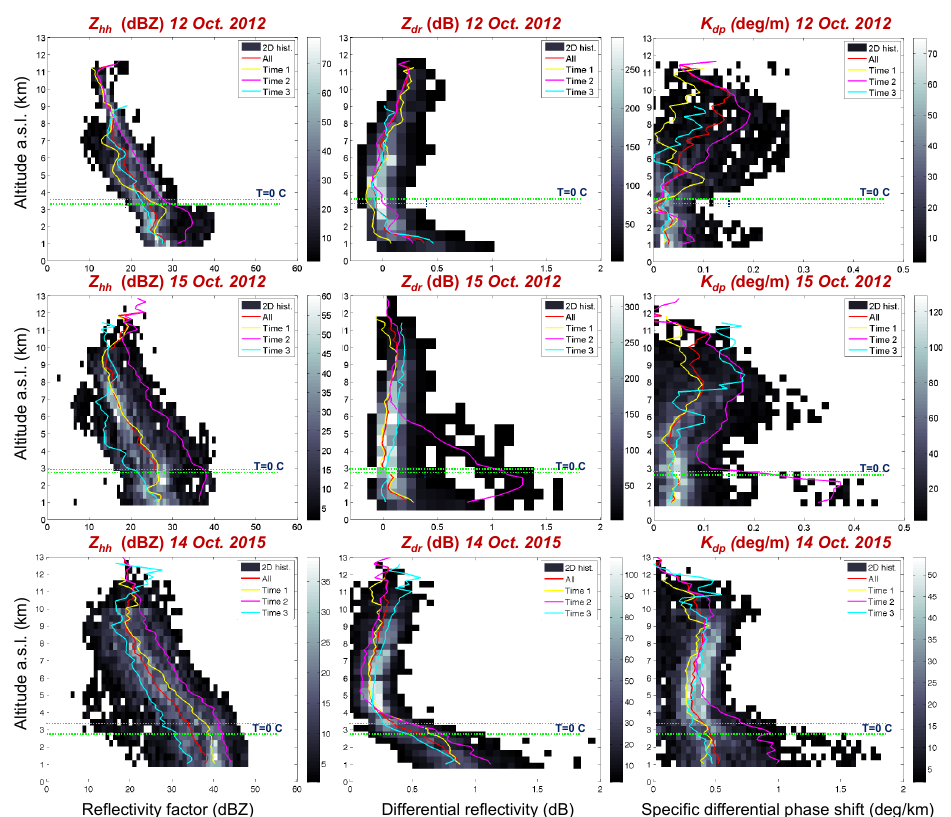
Figure 3. From left to right: average quasi vertical profiles of Z hh (dBZ), Z dr (dB), and K dp (deg · km − 1 ), extracted from three time windows as specified in each panel’s legend and indicated in the left panels of Figure 2. The bi-dimensional histogram of the occurrences of each radar variable is overplayed as well. The horizontal dotted lines indicate the value of zero thermal altitude as registered by the local radiosoundings in Pratica di Mare (id station 16245 LIRE) at 00 UTC and 12 UTC. From top to bottom: case studies on 12 October 2012, 15 October 2012, and 14 October 2015, respectively.